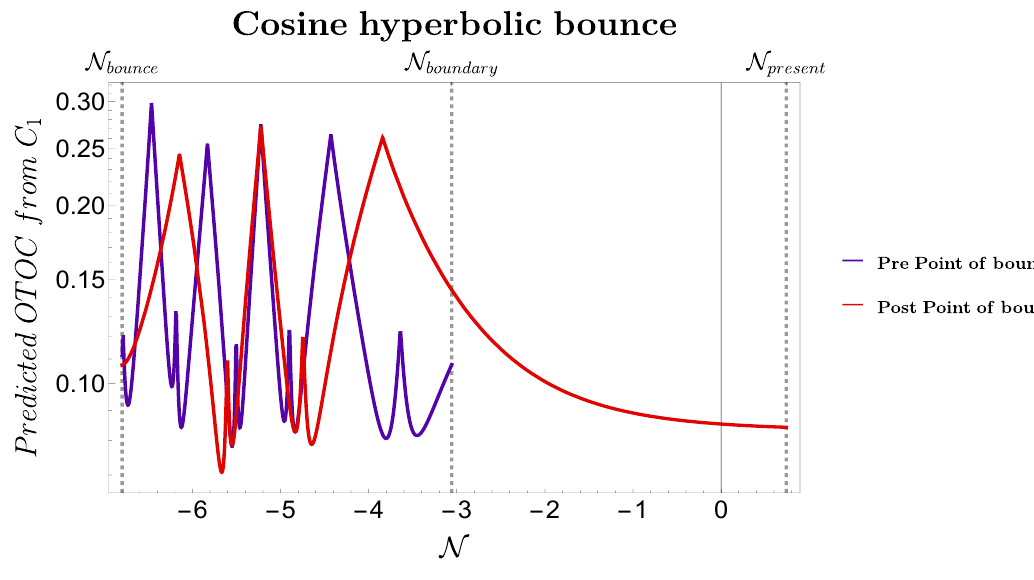
Figure 22: Predicted OTOC from linearly weighted complexity outside bouncing re- gion with respect to number of